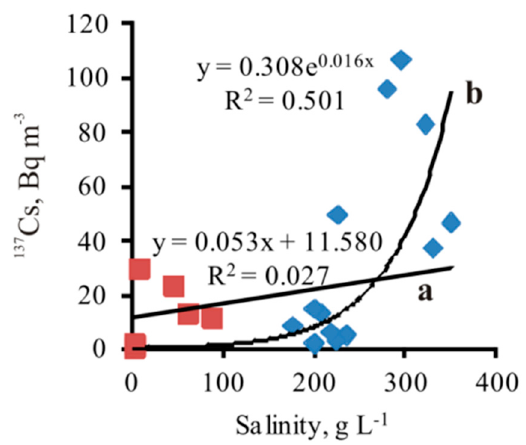
Figure 5. The dendrogram of similarity in relation “salinity — 137 Cs concentration” between samples taken from the studied Crimean lakes (a sample number was given in Table 1).